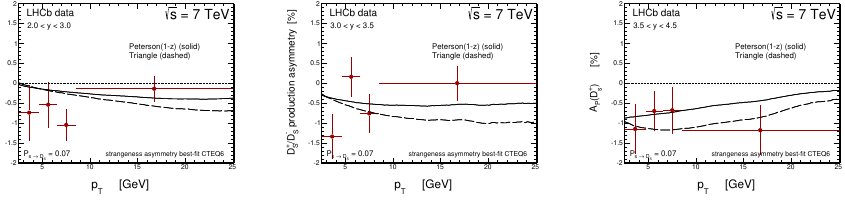
Figure 6. A D + / D − production asymmetry measured by the LHCb collaboration at function of D meson pseudorapidity (left panel) and D meson transverse momentum (right panel).